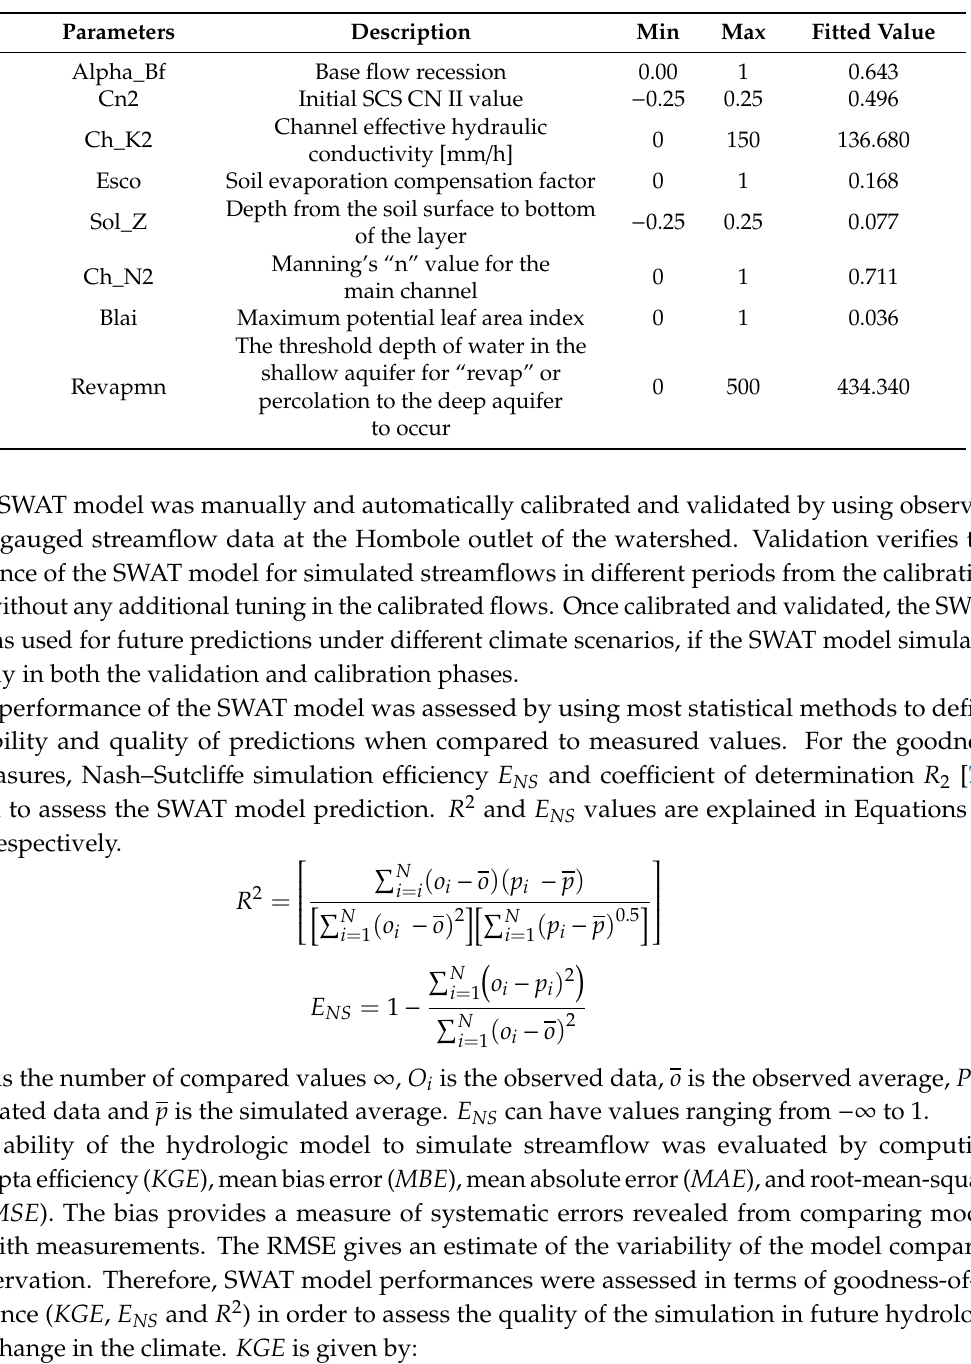
Table 2. Hydrological parameters and their ranges used for model